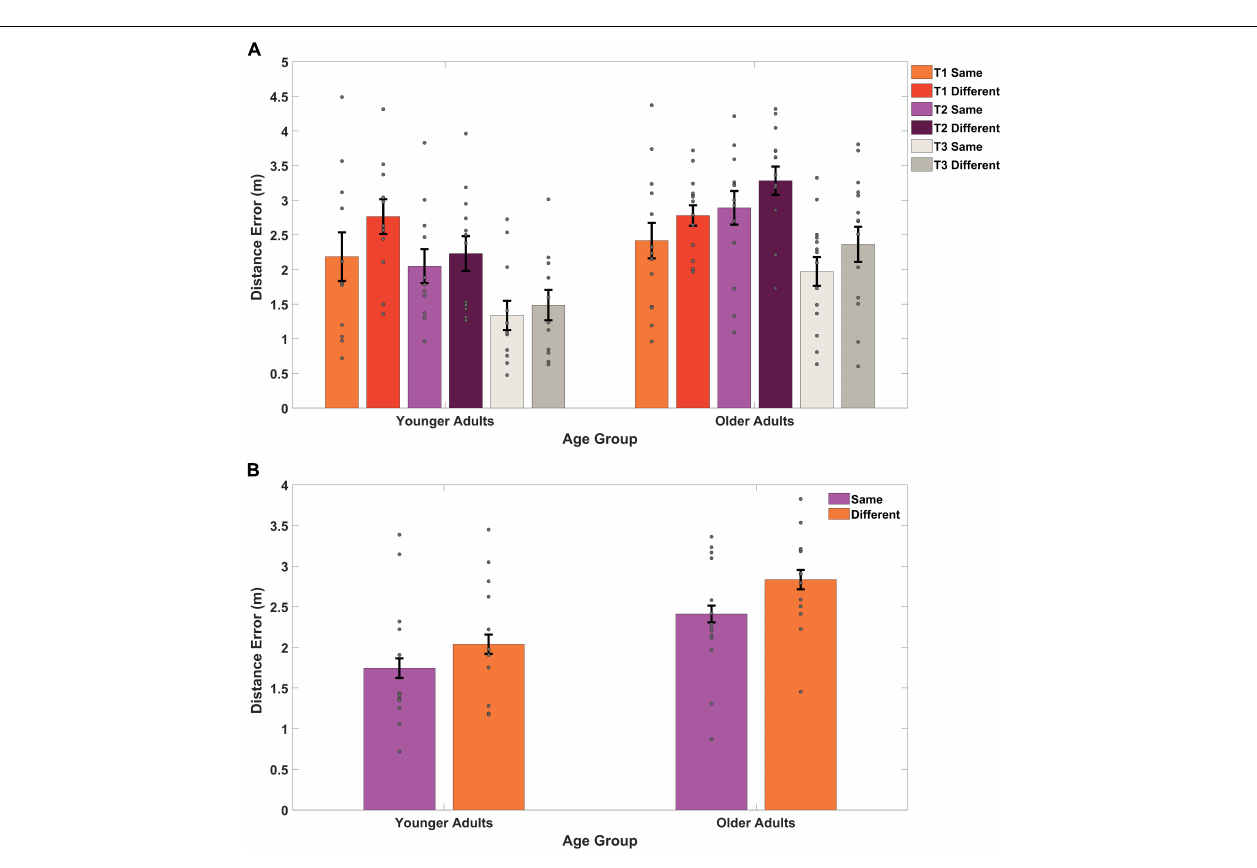
A mixed-effects ANOVA revealed a significant main effect of age group [ F (1,25) = 12.65, p = 0.002, η p2 = 0.34, BF 10 = 674.22], ( M = 2.81, SD = 0.60) in their memory for the position of the hidden target than younger adults ( M = 2.01, SD =